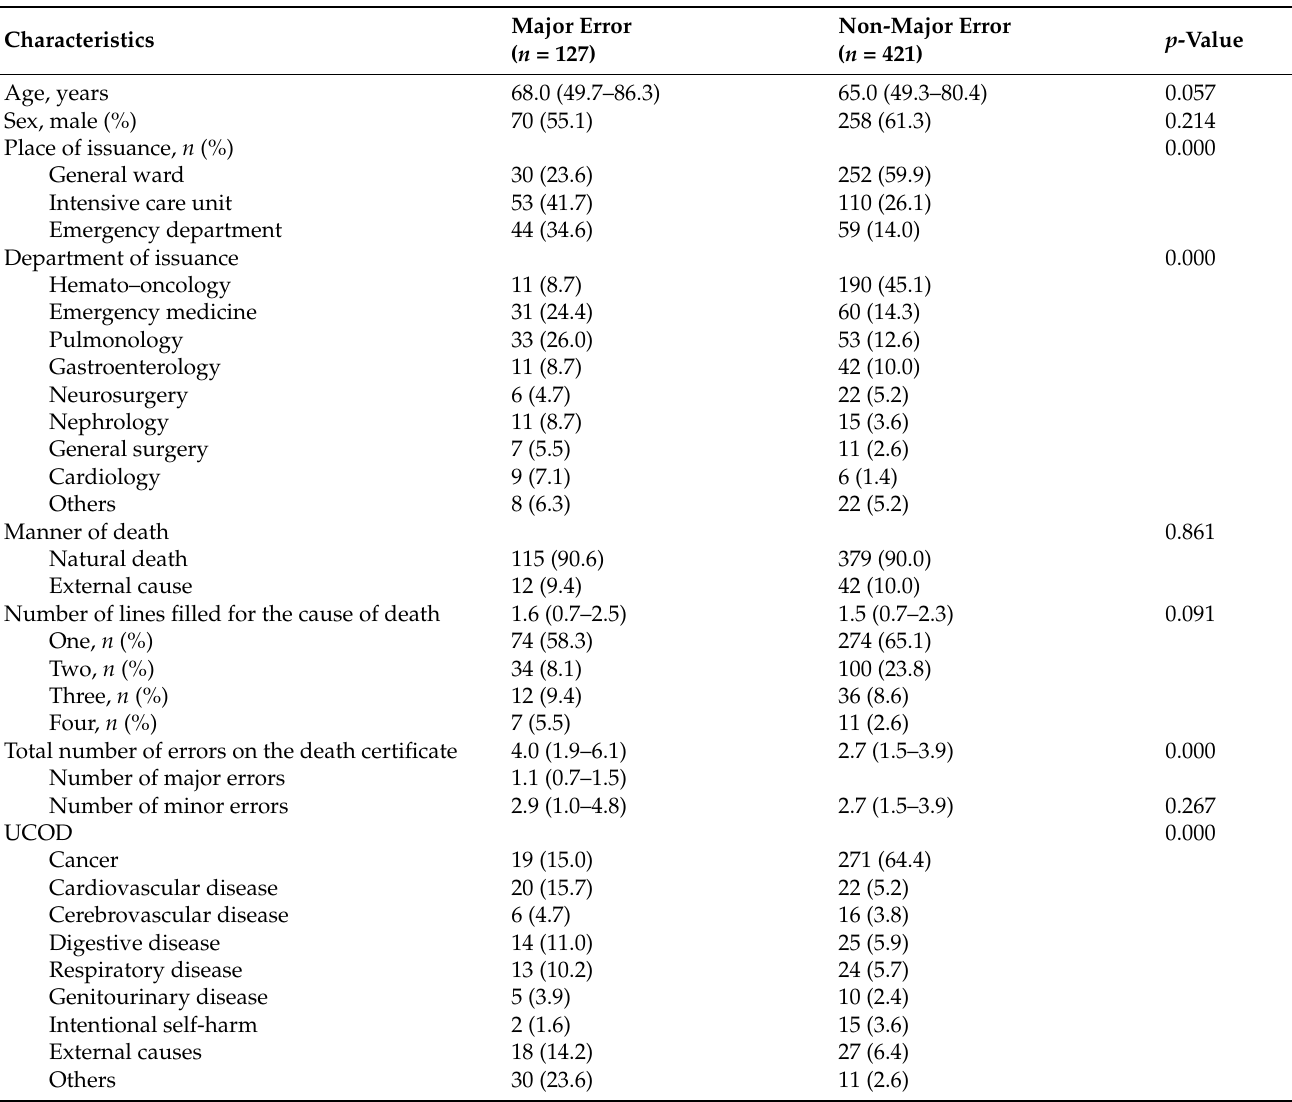
Table 2. Characteristics of death certificates according to major